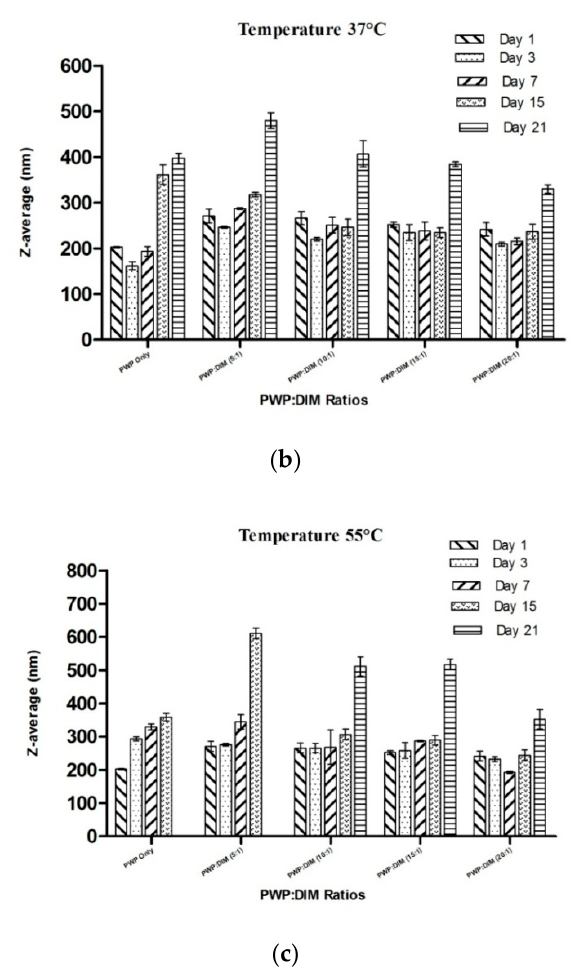
Figure 7. Effect of different storage temperature ( a ) 4 °C ( b ) 37 °C( c ) 55 °C on the mean particle size of PWP/DIM nanoparticles with different ratios during storage. Values are mean ± SD ( n = 3).